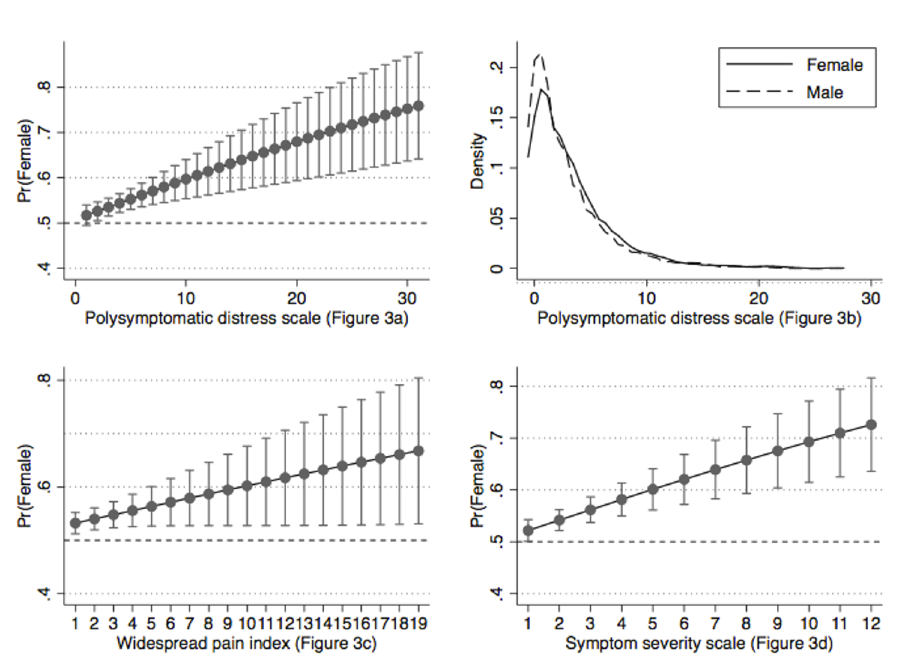
Fig 3. The relation of polysymptomatic distress (PSD) and its components to the sex of rheumatoid arthritis patients in the German general population (S3 File). (2a, 2c and 2d) The proportion of patients who are females increases with greater PSD, WPI and SSS scores. Pr = probability. (B) The distribution of PSD scores is greater and shifted to the right in women compared with men.